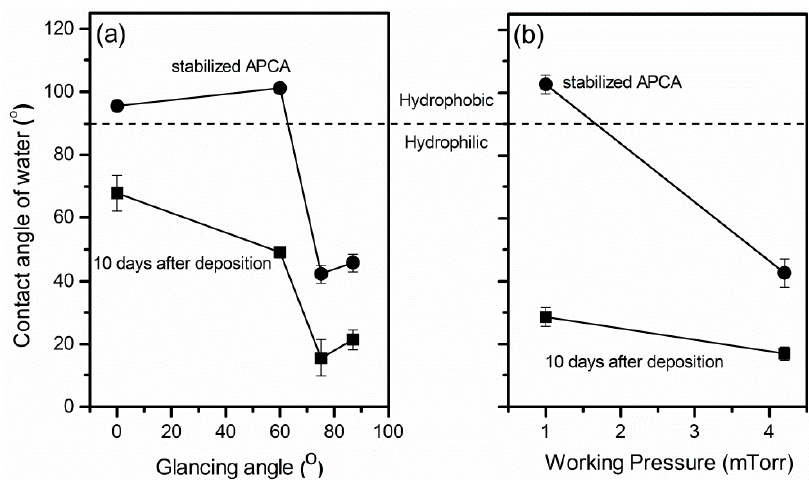
Figure 5. Measured apparent contact angles 10 days after the deposition and after prolonged storage in dark when the surface is stabilized versus ( a ) the glancing angle of the substrate (P t =2.4 mTorr, O 2 content:50%) and ( b ) the working pressure (glancing angle 75°, O 2 content: